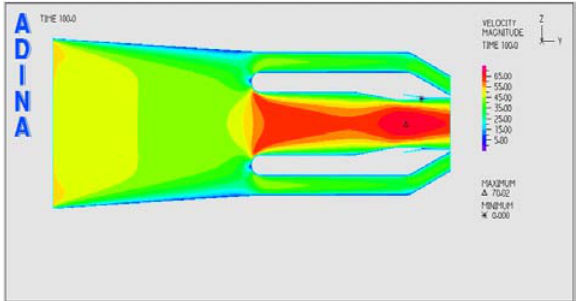
Fig 7. The distribution of air velocity through the injector